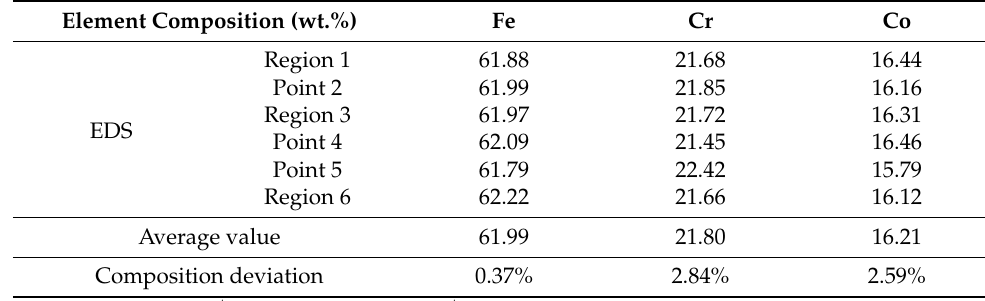
Table 1. Chemical composition of microregions marked in Figure 4c. Element Composition